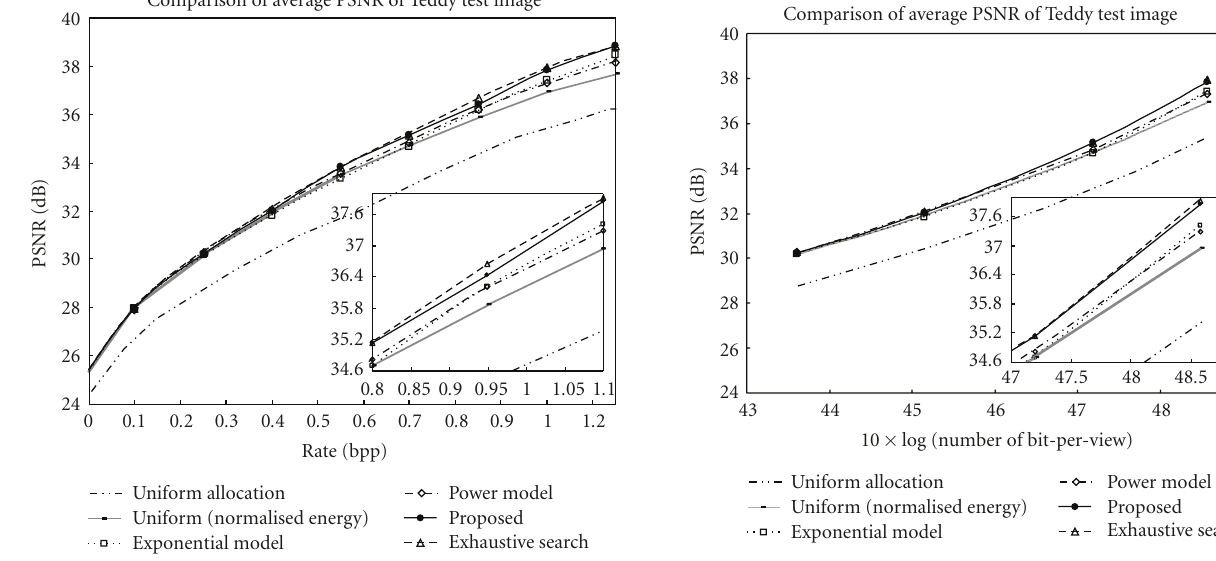
Figure 8: PSNR comparison of Teddy test image when using di ff erent bit allocation methods.